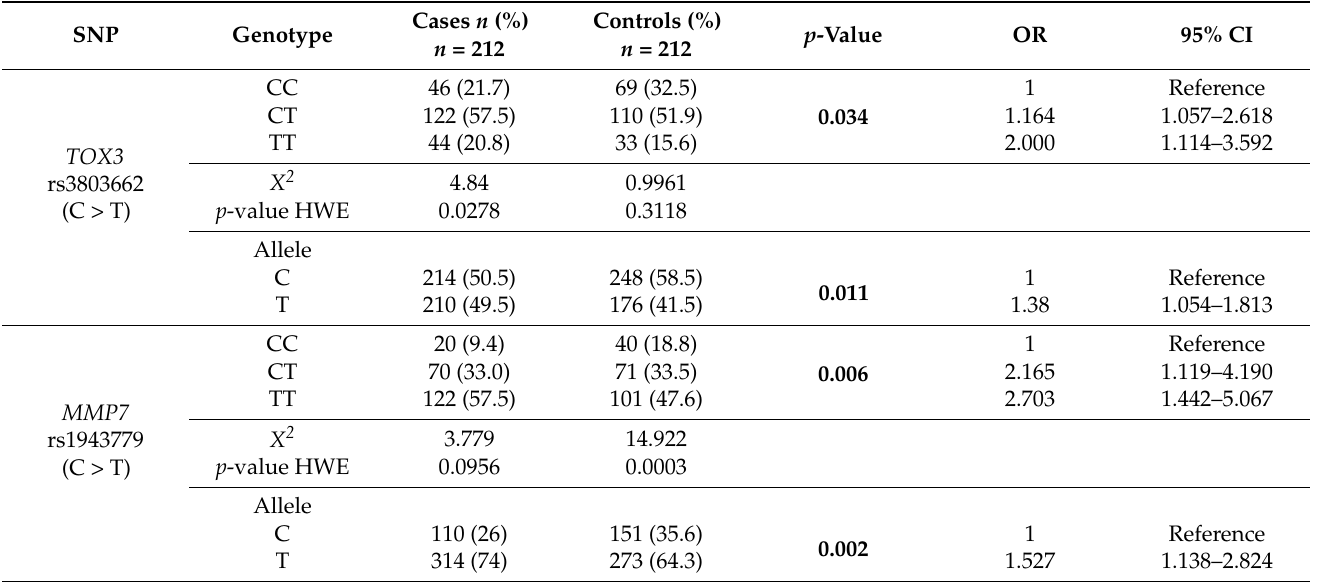
Table 4. Distribution of genotypes and alleles of TOX3 and MMP7 polymorphisms.